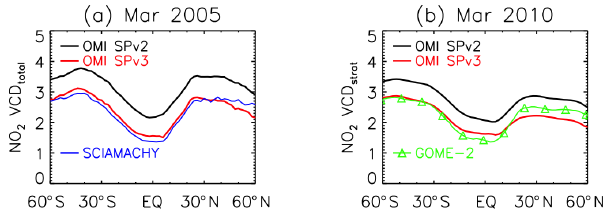
Figure 11. OMI, SCIAMACHY, and GOME-2 retrievals over the Pacific Ocean region (180–140 ◦ W) for (a) VCD total in March 2005 and (b) VCD strat in 2010. The SCIAMACHY and GOME-2 data have been adjusted to the local time of the OMI overpass by making photochemical corrections based on the diurnal variation simulated by the GMI